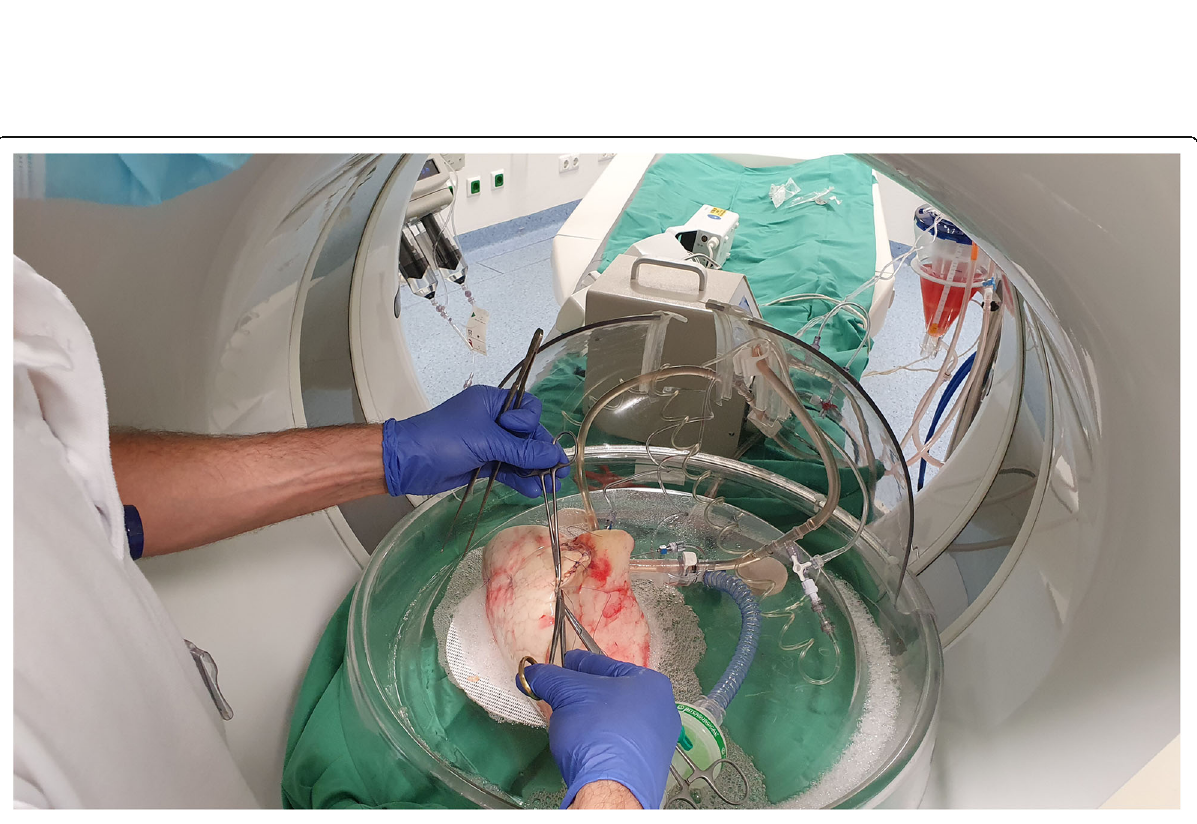
Fig. 3 Surgical biopsy taken from the periphery of the lung lobe for microscopy